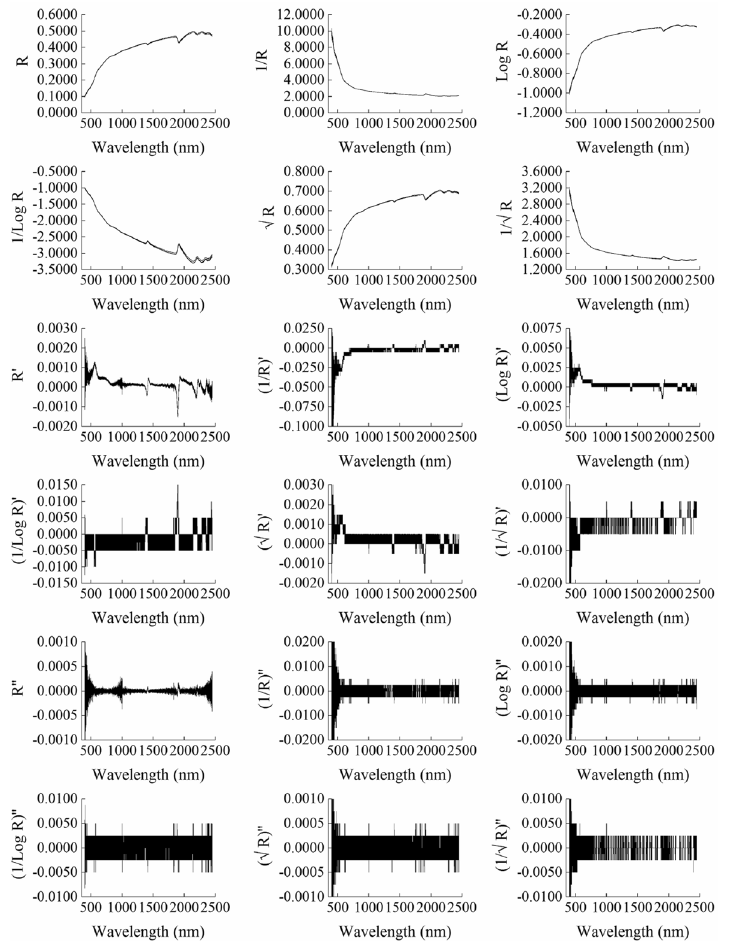
Figure 3. Spectral curves of different preprocessing mathematical